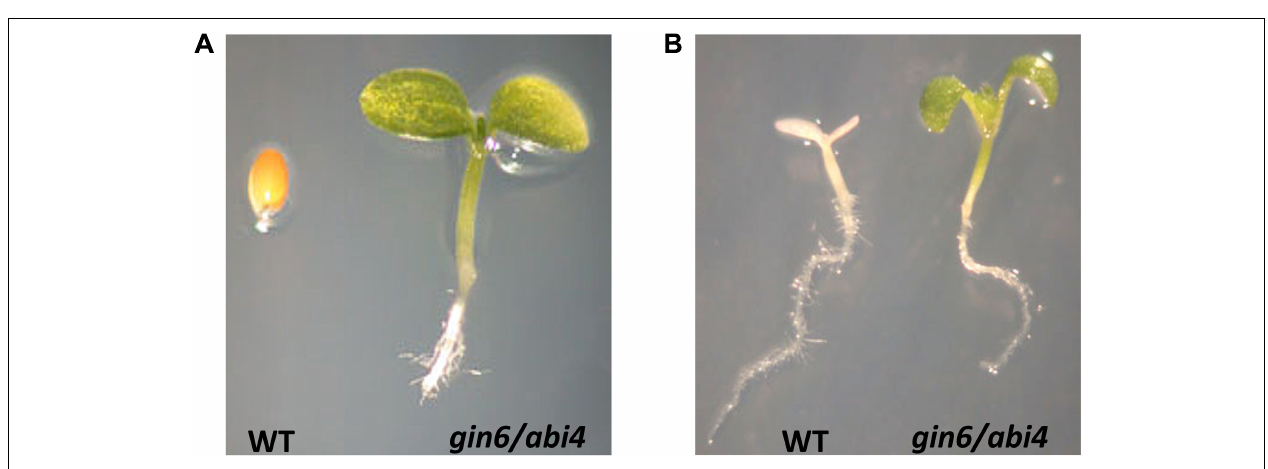
FIGURE 2 |ABI4 is required forABA and sugar signaling. The abi4 / gin6 mutant plant is ABA-insensitive ( abi ) and glucose- insensitive ( gin ). A. thaliana wild-type plants are unable to grow in 5 μ M of ABA, whereas the abi4 mutant plant develops normally (A) . In media